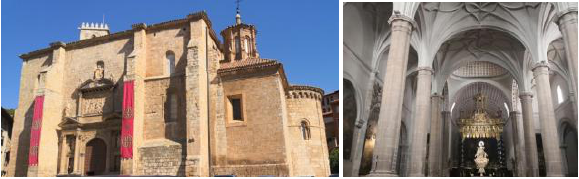
Figure 1. Exterior and interior of Santa María ’s Church. Image by the